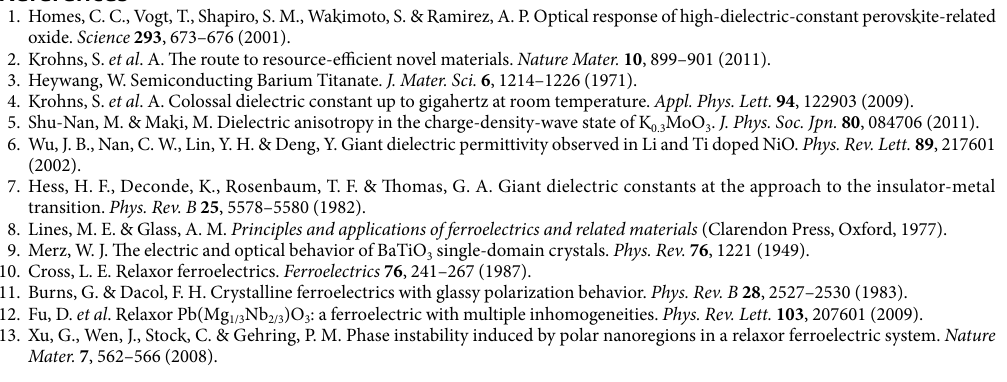
3 triangle and + + Nb Ti A 25 3 forms of + + ̈ In V Ti 23 diamond, whose configurations are closely associated with an O Ti anisotropic crystal structure of TiO 2 . The strong anisotropy in the dielectric response at the low temperature, which has been found in the present study, would thus be caused by the anisotropy in the structures of complex defects in NITO. To increase the complex-defect-induced permittivity further, the defect density must be increased and/or the defect state should be made dispersive. However, such modifications would require a tradeoff with the insulating properties of the material. A next step would be to optimize the defect-induced die- lectric response via the design of the electronic states in the complex defects. Although further quantitative investigation is required, the results of the present study demonstrate that co-doping of Nb 5 + and In 3 + introduces an additional agent that responds to the external electric field in the host TiO 2 matrix and thereby enhances its intrinsic dielectric permittivity. We believe that this work elucidates the potential of defect engineering in increasing the dielectric permittivity of a host matrix and contributing to the development of innovative nanoelectronic and power-electronic devices.